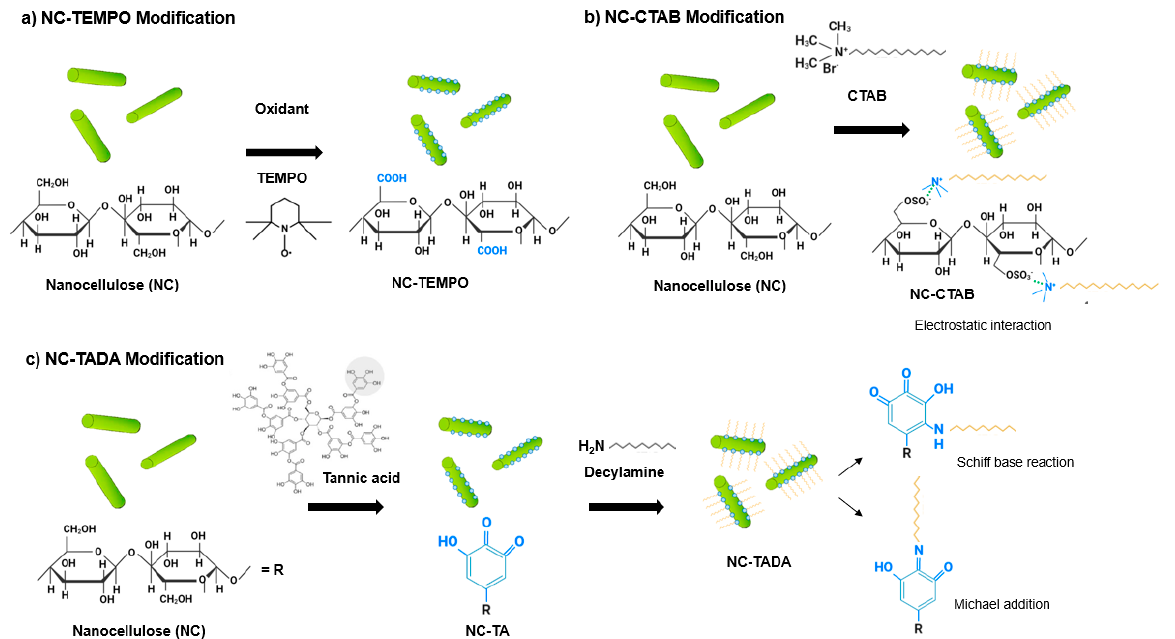
Figure 2. Illustration of ( a ) the nanocellulose-based product obtained by TEMPO-mediated oxidation; and the interaction of nanocellulose (NC) with ( b ) cetyltrimethylammonium bromide (CTAB) and ( c ) tannic acid and decylamine (TADA).